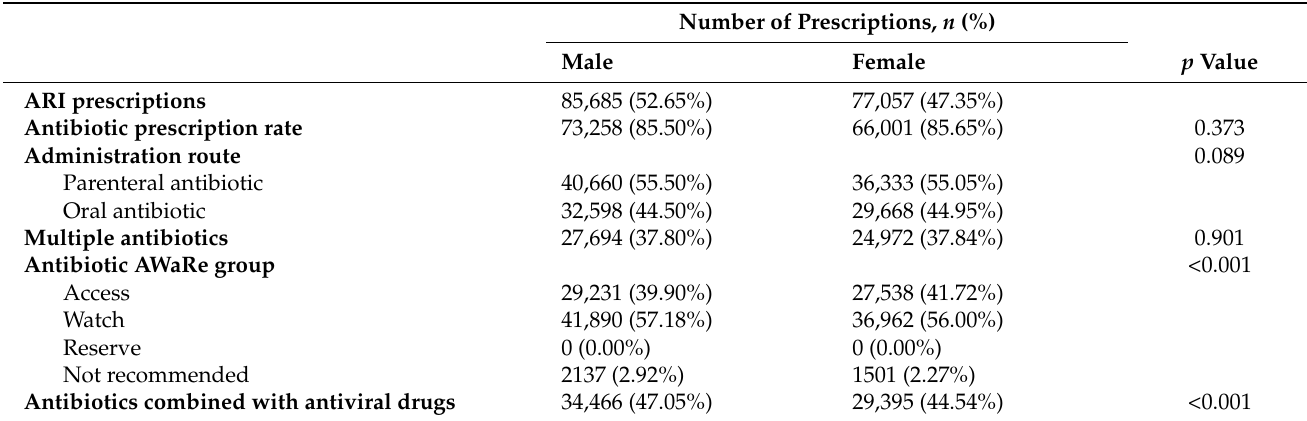
Table 3. Antibiotic prescription patterns stratified by sex a